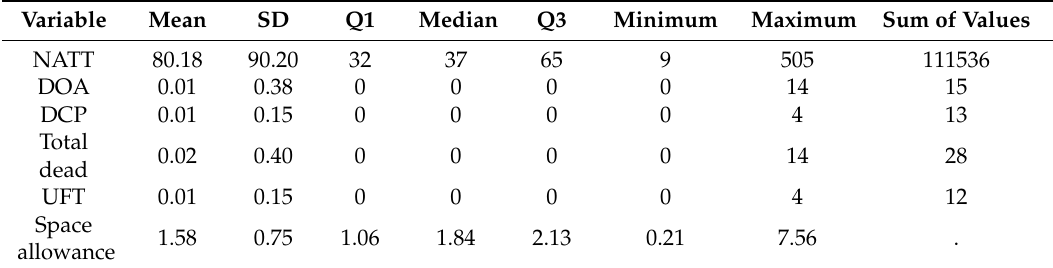
Table 2. Descriptive statistics of the numerical variables for the 1391 trucks which stopped at control post CE 07/PS Bitritto (Bari, Italy) from 2010 to 2015.